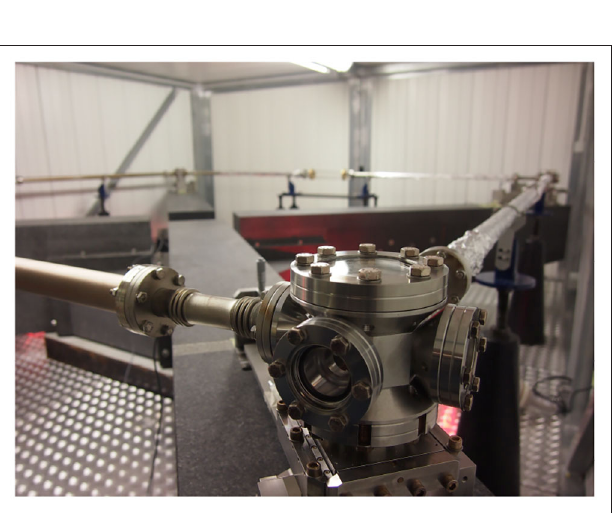
FIGURE 5 | GINGERINO at the time of assembling. The mirror box and the pipes connecting the boxes, one of the Mitutoyo screw to orientate the mirrors is visible in front of the box. The mechanical structure is in steel, and the whole is attached to the granite monument, cross shaped, which provides stability of the ring